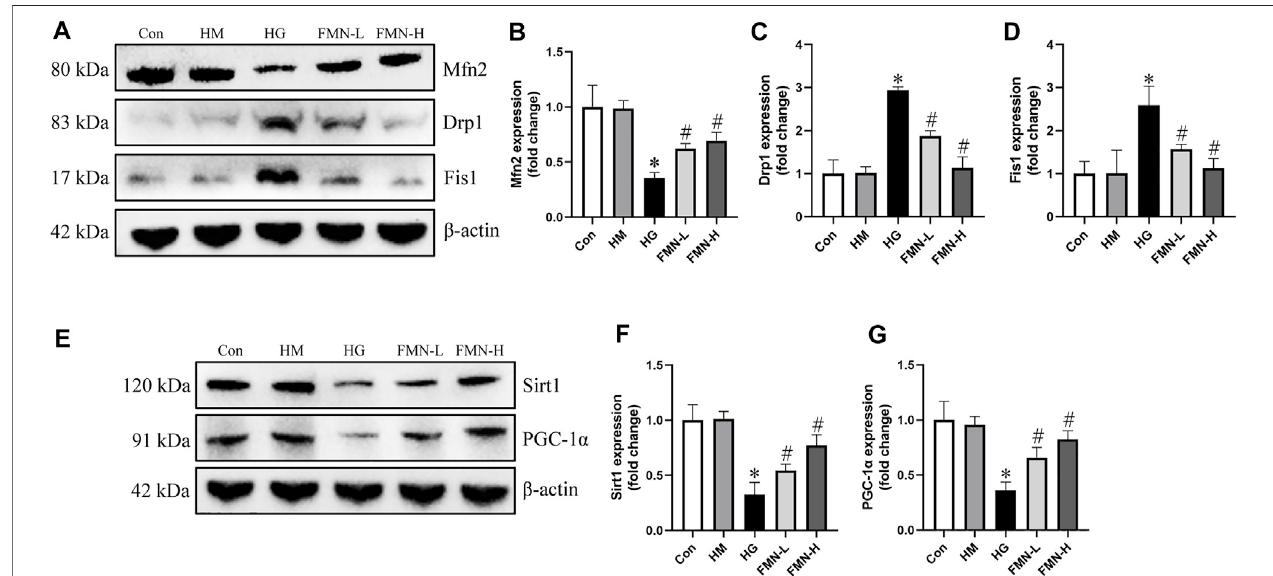
FIGURE 8 | FMN restored the expression of mitochondrial dynamics-associated proteins and Sirt1/PGC-1 α . (A – D) Representative Western blot images of Mfn2, Drp1 and Fis1 protein expression and semiquantitative analyses in different groups. (E – G) Western blot analyses and semiquantitative analyses of expression of Sirt1 and PGC-1 α . Results were expressed as mean ± SD. * p < 0.05 vs. control group. # p < 0.05 vs. HG